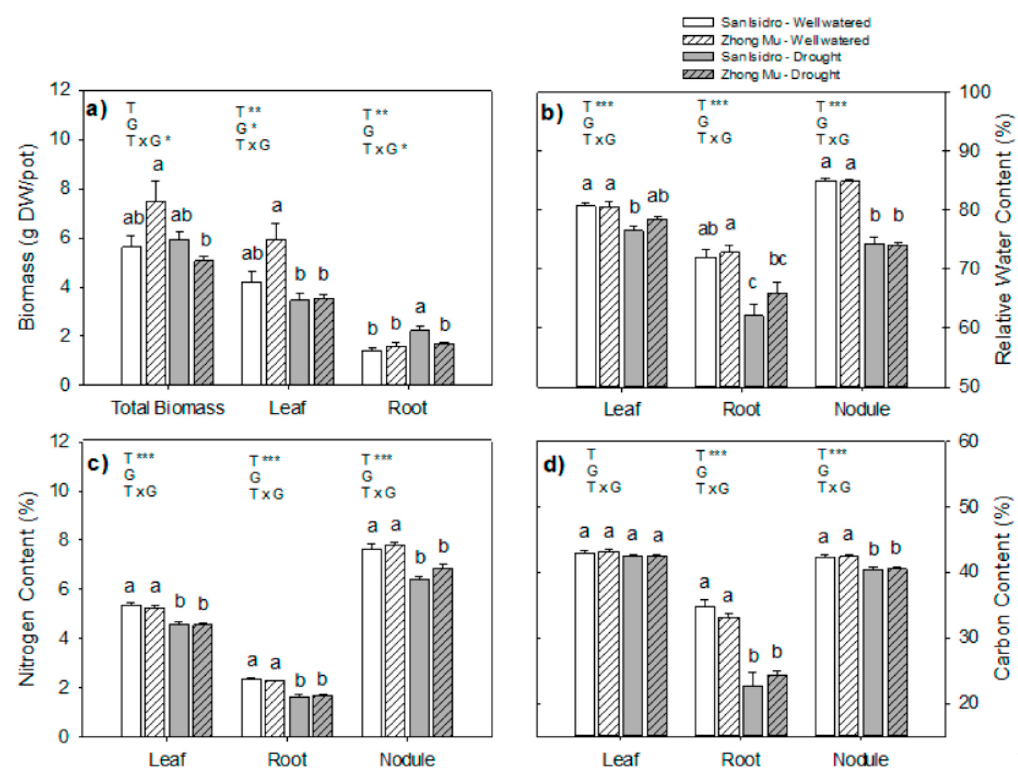
Figure 1. Agro-physiological parameters under control and drought conditions in two cultivars of Medicago sativa: San Isidro and Zhong Mu. ( a ) Dry biomass (g DW / pot); ( b ) relative water content (%); ( c ) nitrogen content (%) and ( d ) carbon content (%). Each value represents the mean ± SE ( n = 6). The di ff erent letters indicate significant di ff erences ( p < 0.05). Asterisks indicate significant di ff erences: * p < 0.05, ** p < 0.01, *** p < 0.001, in the two-way ANOVA for water-stress and